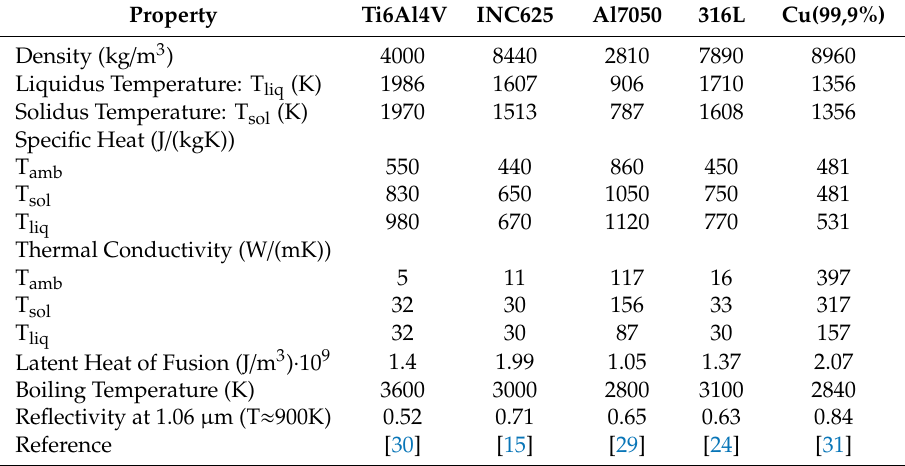
Table 1. Thermo-physical properties used in the model for the five commercial alloys used for the calibration. Experimental data have been found in the references shown in the